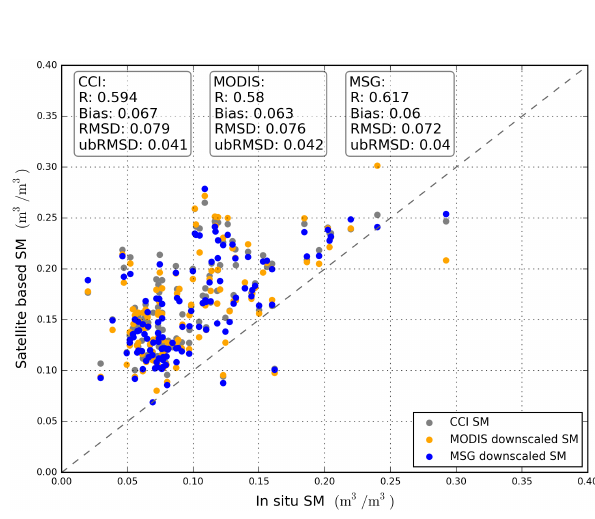
Figure 8. Scatter plots of the REMEDHUS network-averaged esti- mates and soil moisture measurements. The corresponding compar- ison statistics are shown as